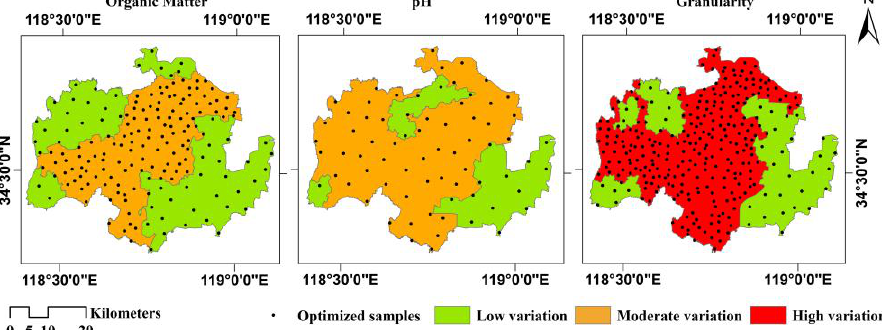
Figure 3. Spatial distribution of sample points for the three soil properties after optimization with the improved simulated annealing (SA).